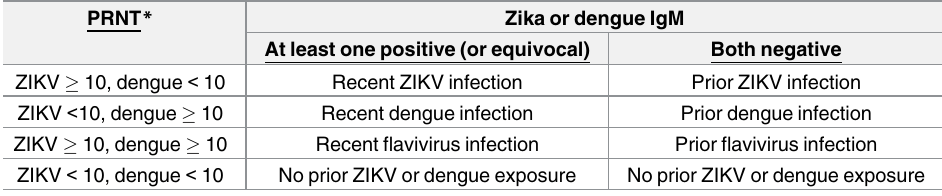
Table 1. Interpretations of antibody testing and sample